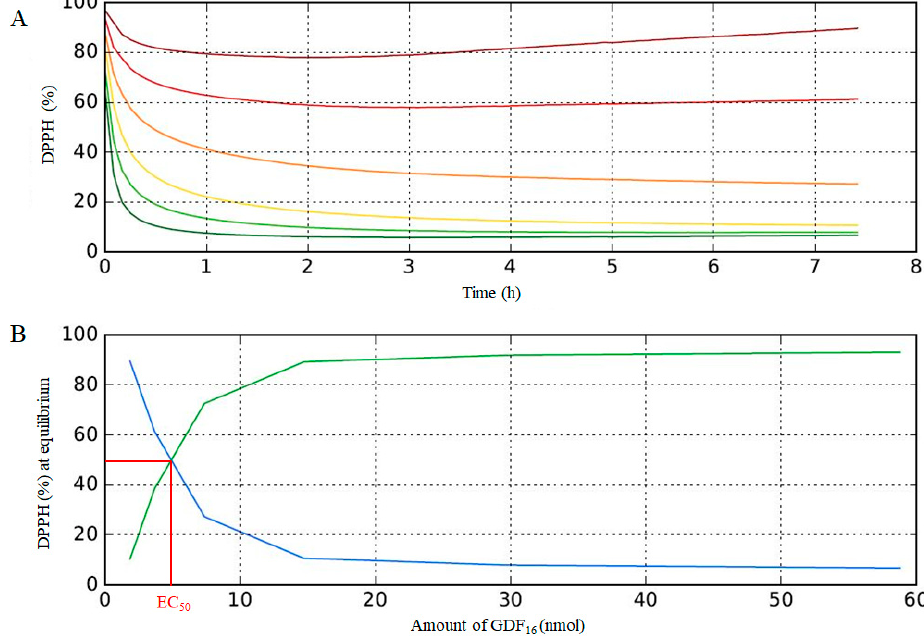
Figure 8. ( A ) Reaction kinetics of GDF 16 solution at given concentrations: 300 µ M (dark green), 150 µ M (light green), 75 µ M (yellow), 37.5 µ M (orange), 18.8 µ M (red), and 9.4 µ M (brown), ( B ) EC 50 determination for GDF 16 . Blue line: 2,2-diphenyl-1-picrylhydrazyl (DPPH) radical and Green line: RPPH reduced.